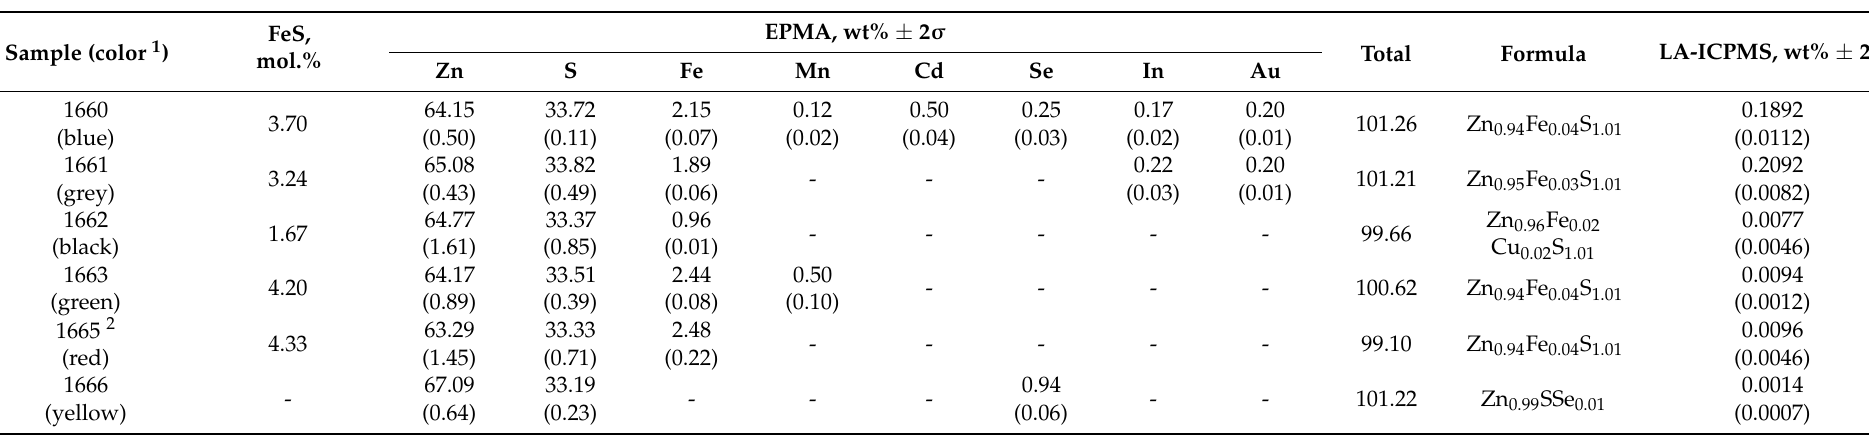
Table 27. Concentration of Au in the samples of synthetic sphalerite doped by different admixtures, grown using the salt flux method (in eutectic melts of NaCl/KCl) at 850 ◦